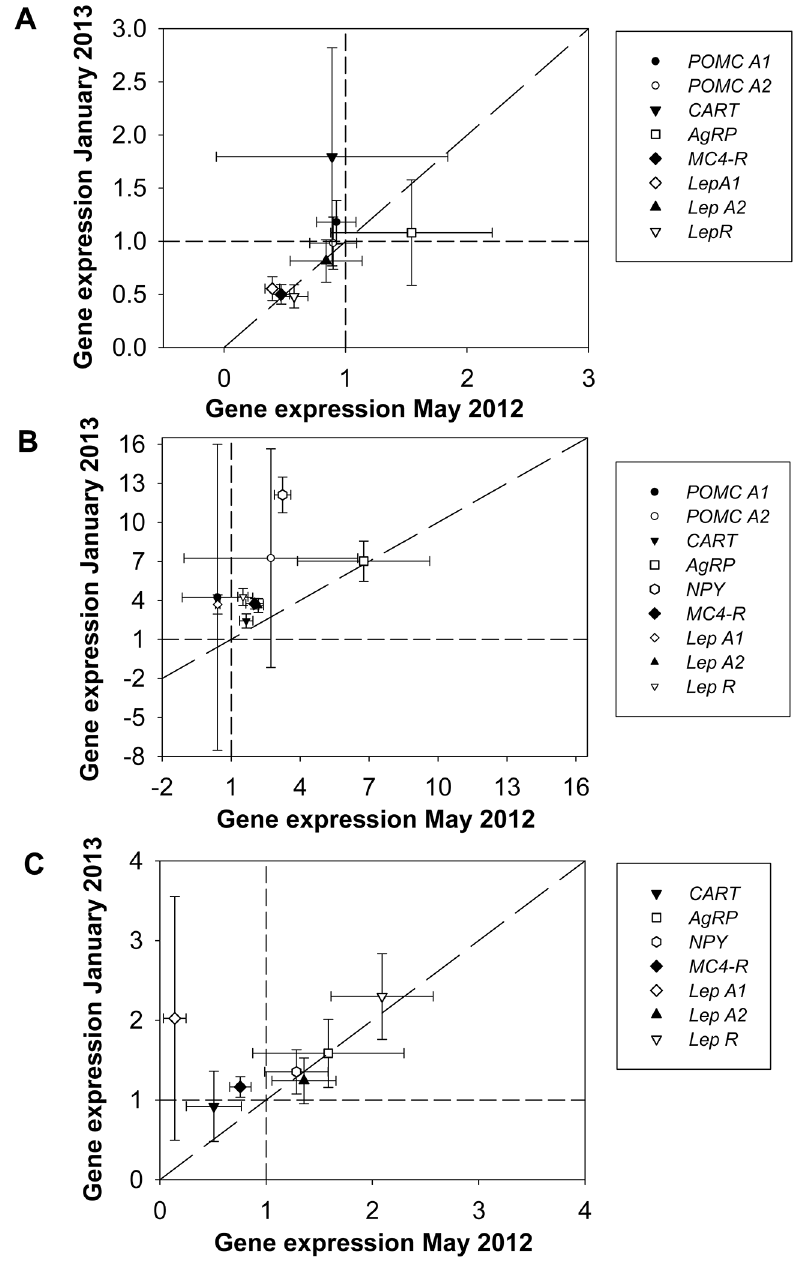
Fig 2. Relative gene expression in the hypothalamus (A), the mesencephalon (B), and the telencephalon (C) in May 2012 and January 2013. Expression levels in brain compartments sampled in May 2012 and January 2013 are presented relative to those sampled in July 2012 (July data were used as calibrator samples and were set equal to one as indicated by the dashed line). Data are presented as mean (n = 8 – 10) ±